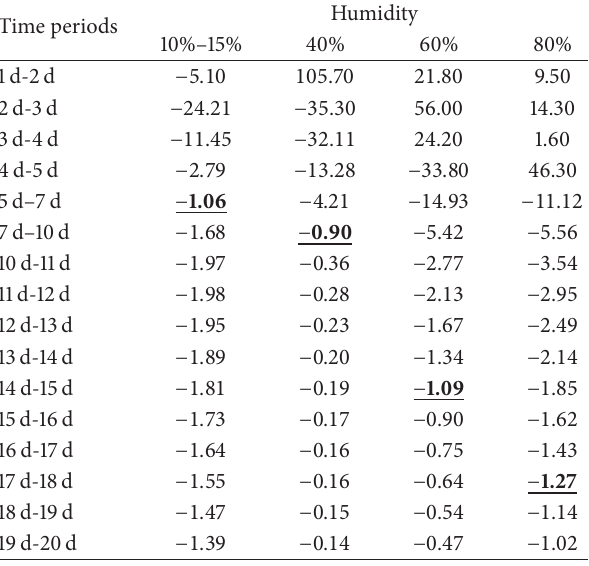
Table 4: The relationship between the strength increase rate and curing humidity (uniaxial compressive strength variation rate, kPa/d).